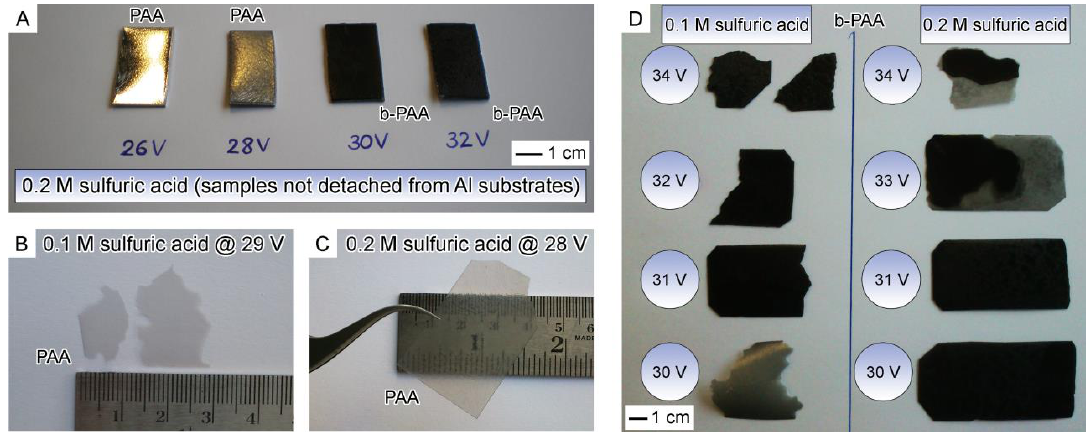
Figure 1. Gradual color and transparency changes in anodic alumina upon the stepwise increase of anodizing voltages is illustrated by samples obtained from 0.2 M H 2 SO 4 electrolyte ( A ) together with the underlying polished metallic substrates. The visual appearance of highly reflective Al-surface beneath alumina layers in ( A ) clearly shows how their optical properties change from highly transparent at 26 V to translucent and moderately lusterless at 28 V, and further to deep black and opaque at 30 and 32 V. All transparent PAA ( B , C ) and opaque black b-PAA films ( D ) obtained from 0.1 M and 0.2 M H 2 SO 4 electrolytes at varied voltages of 29–34 V and 28–34 V, respectively, can be detached from metallic substrates and obtained as unsupported (free-standing) samples by the polarity reversal